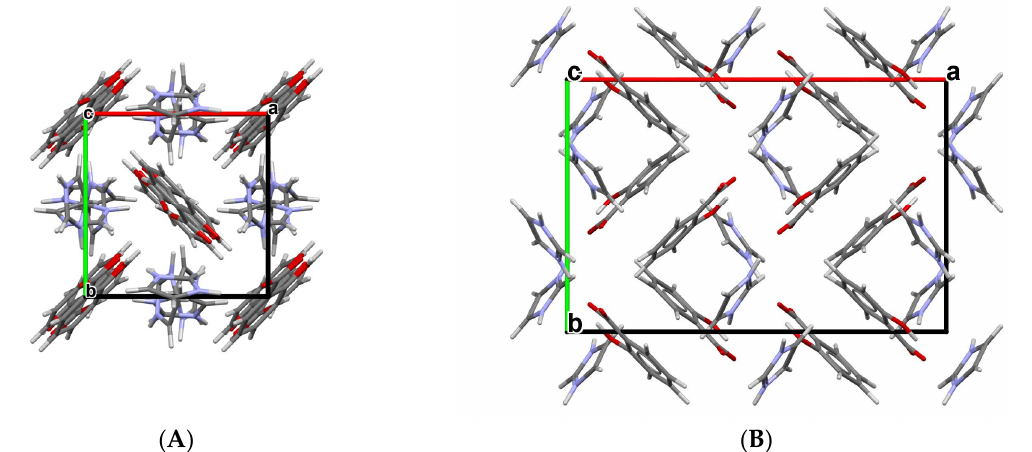
Figure 3. Crystal packings of two polymorphs of SA:IMI (1:1) cocrystal viewed along the c -axis: ( A ) tetragonal polymorph (NIJDOB) and ( B ) orthorhombic polymorph (NIJDOB02).